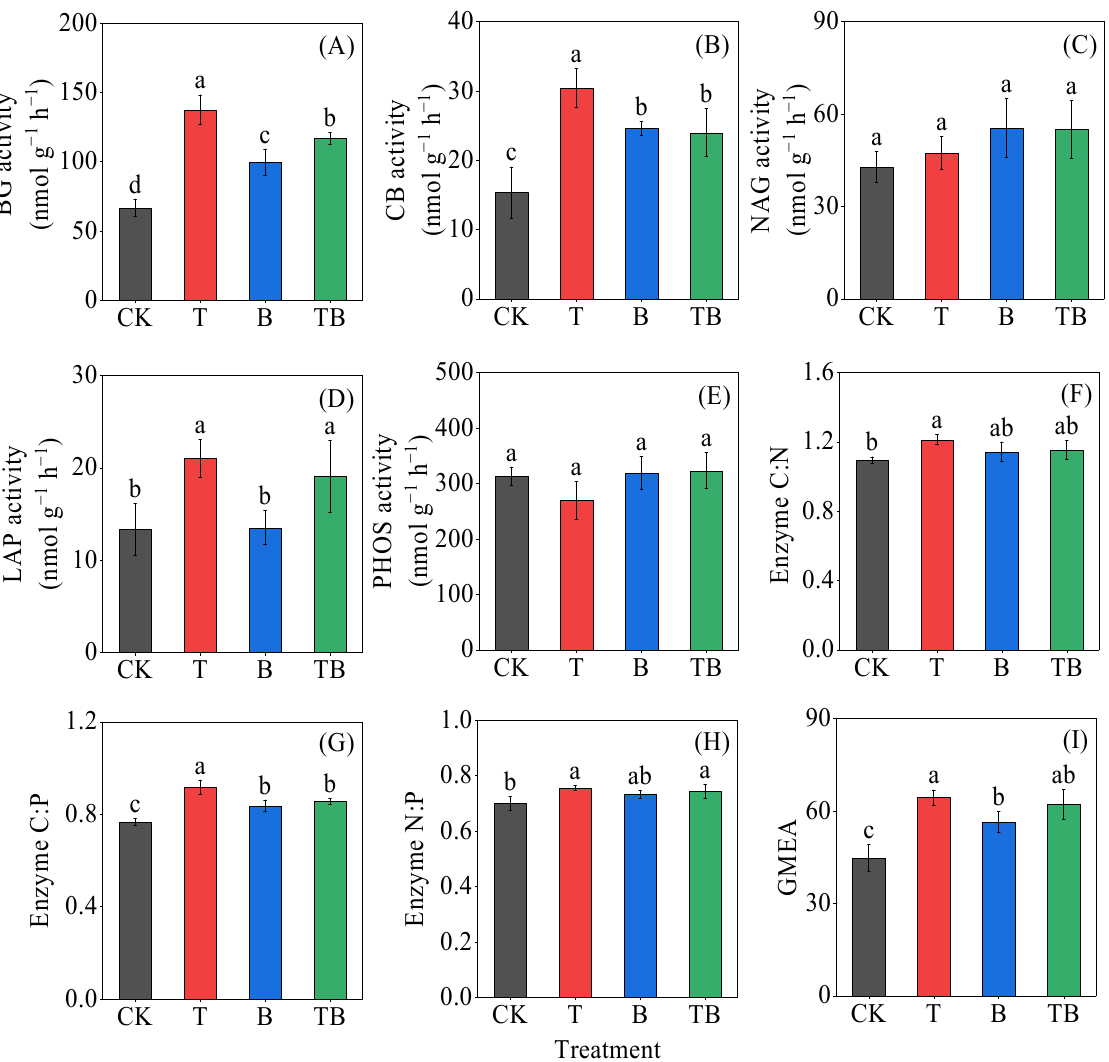
Figure 3. A comparison of soil enzyme activities ( A – E ) and their C:N:P ratios ( F – H ) and the geometric mean of the assayed enzyme activities (GMEA) ( I ) (mean ± SE) among the different treatments, including the control (CK), oyster shell powder (T), biochar (B) and a combined amendment (TB). BG, β− glucosidase; CB, cellobiohydrolase; NAG, N − acetylglucosaminidase; LAP, leucine ami- nopeptidase; PHOS, acid phosphatase; Enzyme C:N means ln (BG + CB): ln (NAG + LAP); Enzyme C:P means ln (BG + CB): ln PHOS; Enzyme N:P means ln (NAG + LAP): ln PHOS. Bars with different letters indicate significant differences ( p < 0.05).